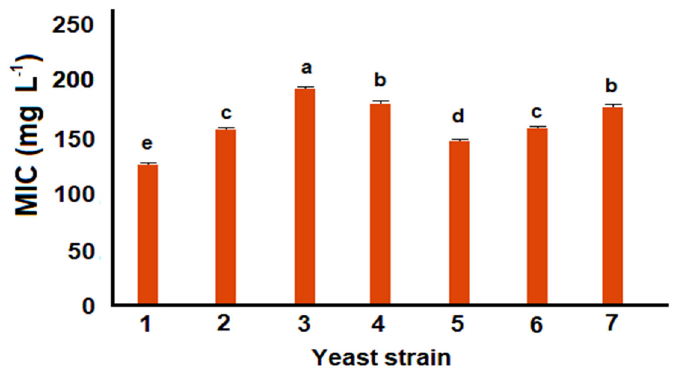
Figure 2. Minimum inhibitory concentration (MIC) for wild and recombinant strains of S. cerevisiae treated with p -coumaric acid. Diverse letters indicate statistically significant differences ( p < 0.01).